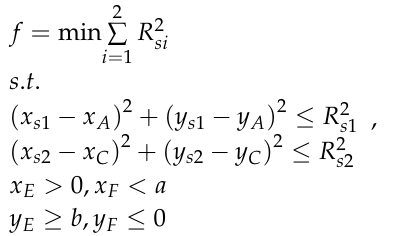
Figure 4. Frame format of a handshake packet in the distributed power control algorithm (DPCA).